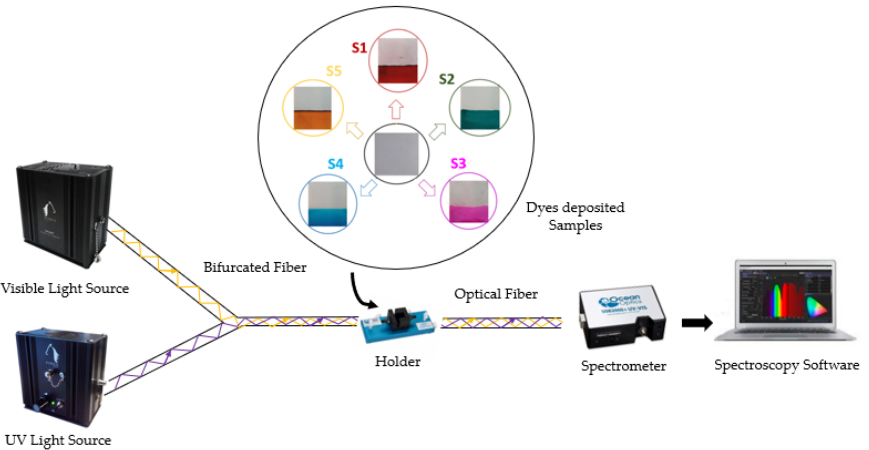
Figure 3. Schematic representation of the photocatalytic test.